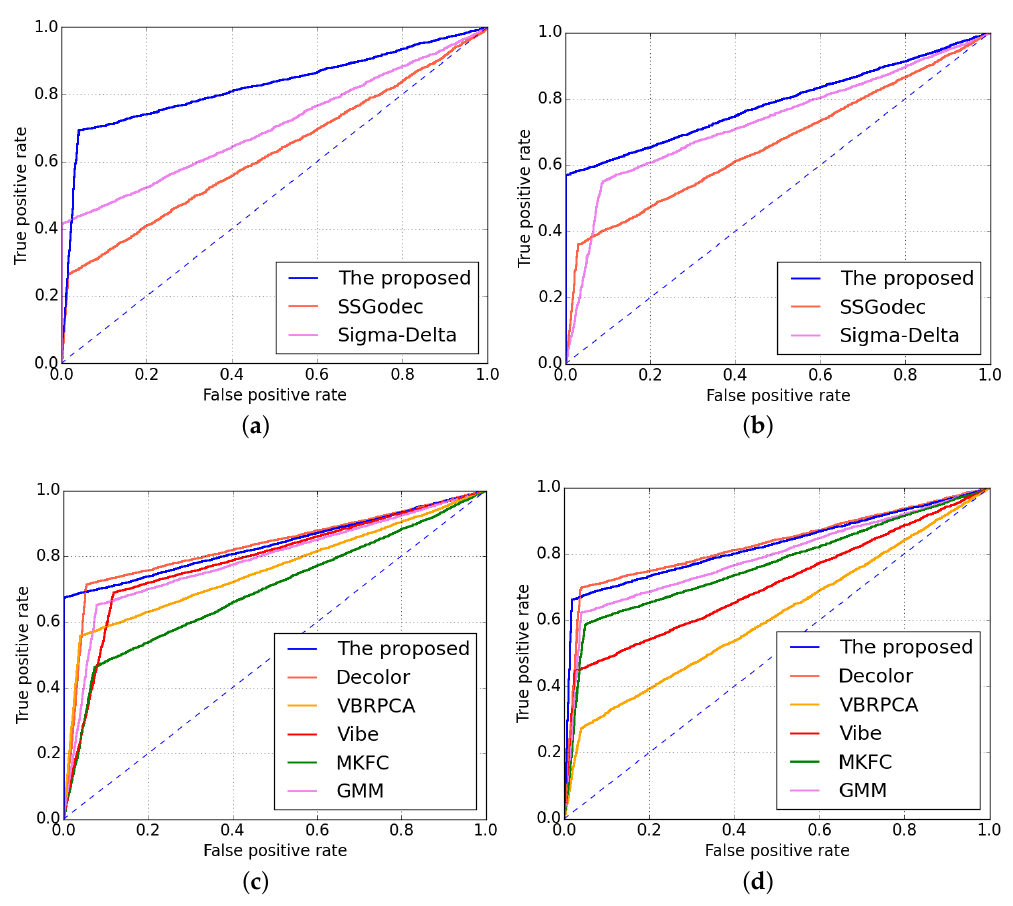
Figure 12. ROC curves for different test sequences based on several detection methods. ( a ) BQSquare ; ( b ) Stefan ; ( c ) PeopleShade ; ( d ) Highway